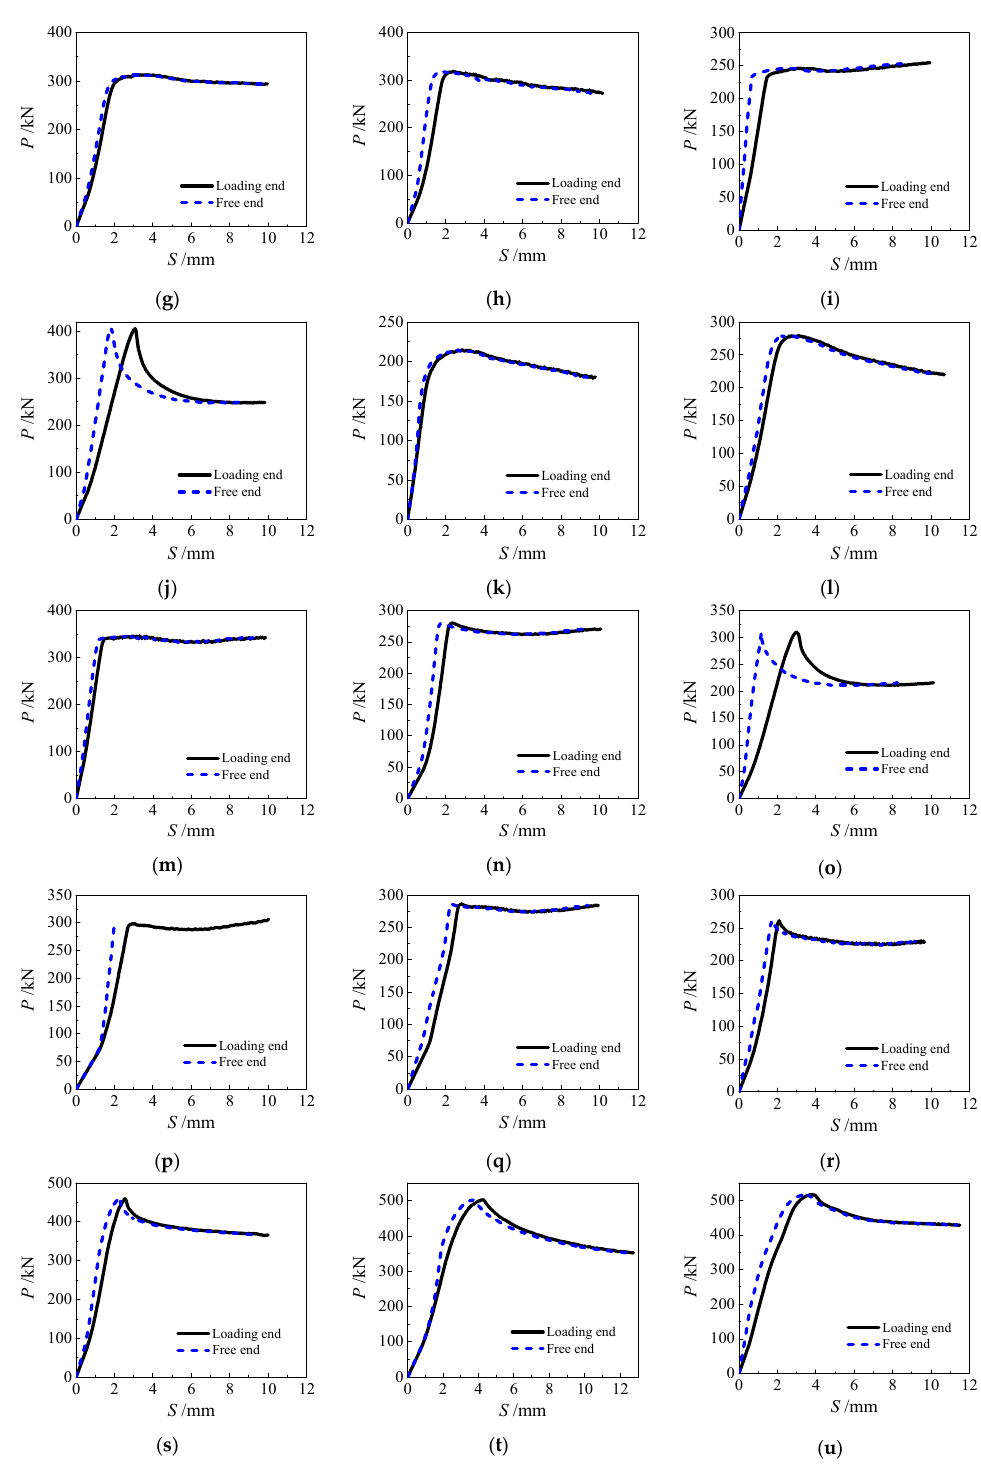
Figure 10. Load-slip curves of specimens ( a ) HSCFST-1W; ( b ) HSCFST-2W; ( c ) HSCFST-3W; ( d ) HSCFST-4W; ( e ) HSCFST-5W; ( f ) HSCFST-6W; ( g ) HSCFST-7W; ( h ) HSCFST-8W; ( i ) HSCFST-9W; ( j ) HSCFST-10W; ( k ) HSCFST-11W; ( l ) HSCFST-12W; ( m ) HSCFST-13W; ( n ) HSCFST-14W; ( o ) HSCFST-15W; ( p ) HSCFST-16W; ( q ) HSCFST-17W; ( r ) HSCFST-18W; ( s ) HSCFST-19W; ( t ) HSCFST-20W; ( u ) HSCFST-21W.